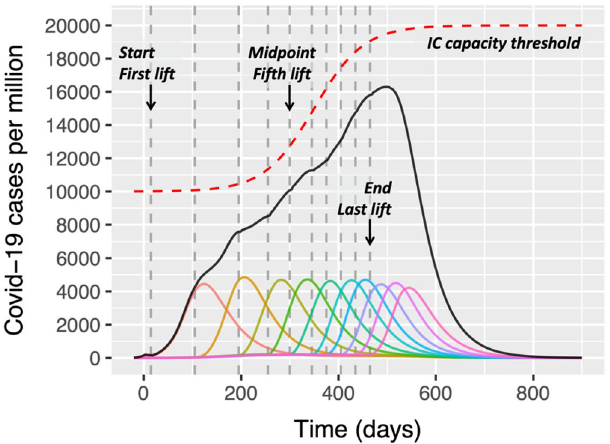
Figure 3. Illustration of a phased lift of control with optimized timing of phases in response to a doubling of IC